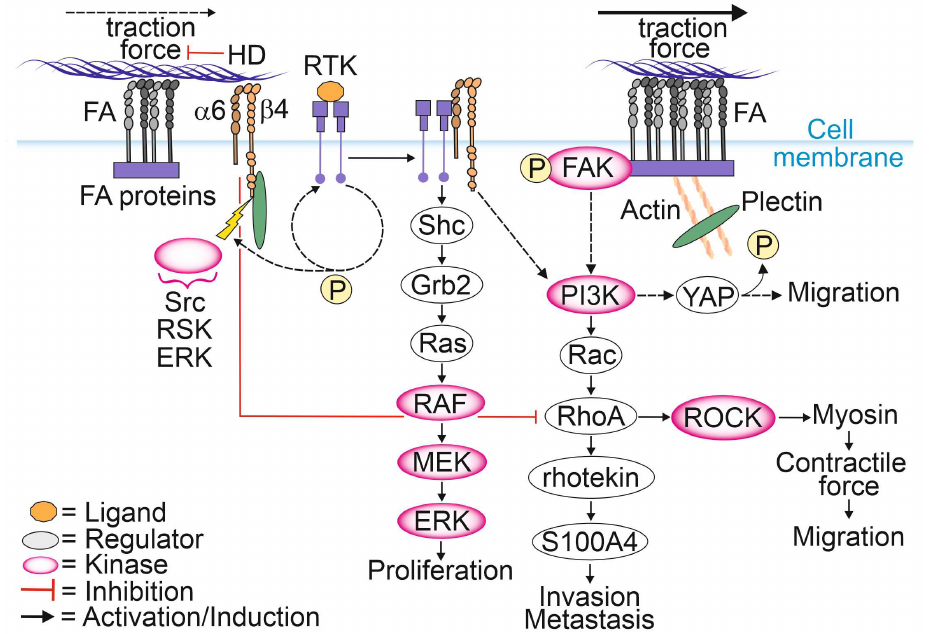
Figure 1. Involvement of α6β4-integrins and plectin in the regulation of cell proliferation and mi- gration.